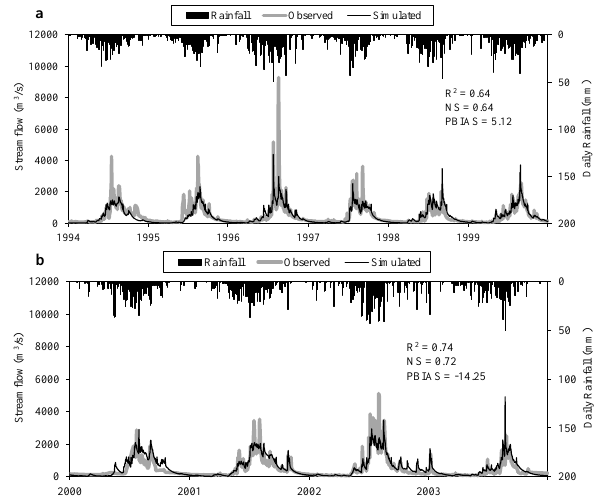
Fig. 7. Daily rainfall and comparison of measured and simulated daily flows for (a) calibration and (b) validation periods.